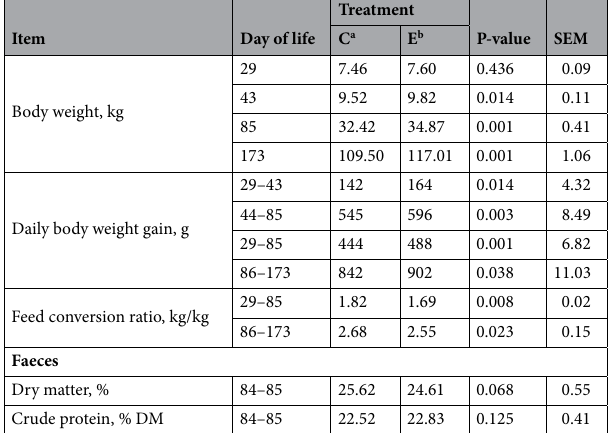
Table 3. Effect of dietary halloysite supplementation on production indices of pigs after weaning and dry matter and crude protein concentration in the faeces of piglets. a Control group fed complete mixtures without halloysite. b Experimental group fed complete mixtures with halloysite addition.